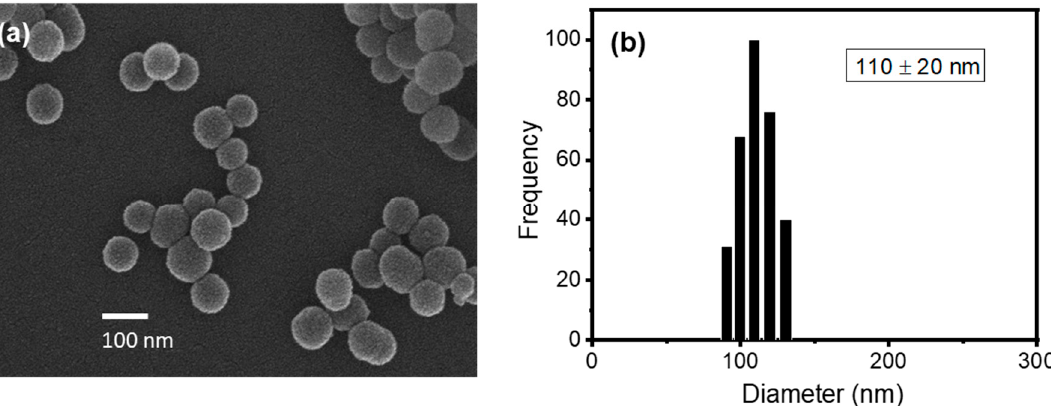
Figure 1. ( a ) SEM image of Cys-encapsulated liposomes and ( b ) size distribution of liposomes measured by DLS. The liposomes were formulated with DMPC:Chol molar ratio of 40:60. The liposomes formulated from the DMPC:Chol molar ratios of 40:60 and 60:40 were characterized by 1 H NMR spectroscopy (Figure 2). Liposomes were prepared through the hydration of lipid films and extrusions as described above, and they were lyophilized and redissolved in CDCl 3 for the 1 H NMR measurements. Next, 1 H NMR spectra were rec- orded on a Bruker BioSpin Avance III 400 NMR spectrometer operating at 400 MHZ for 1 H nucleus. The spectra were referenced to tetramethylsilane (TMS) at 0 ppm. The com- position of liposomes was determined by comparing the integration of characteristic peaks of DMPC and cholesterol. In the 1 H NMR spectrum of DMPC, the methyl protons in the trimethyl ammonium group (9H) appeared as a clear singlet at 3.36 ppm, which